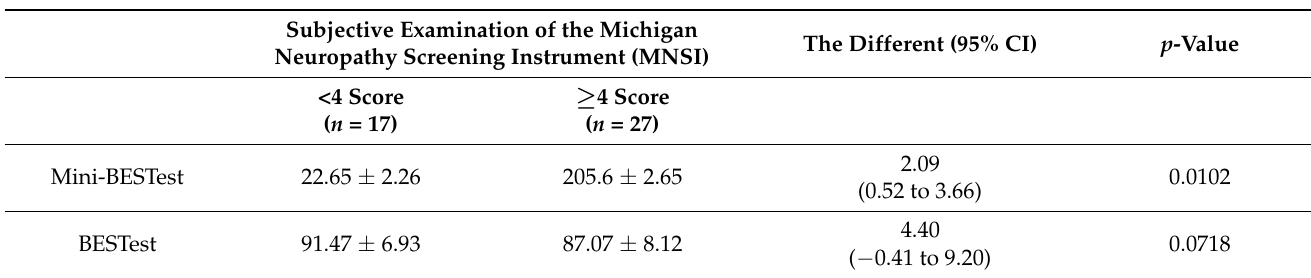
Table 4. Comparison of the scores of the Mini-BESTest and the BESTest between the participants reporting MNSI’s subjective examination scores between ≥ 4 versus <4 ( n = 44).